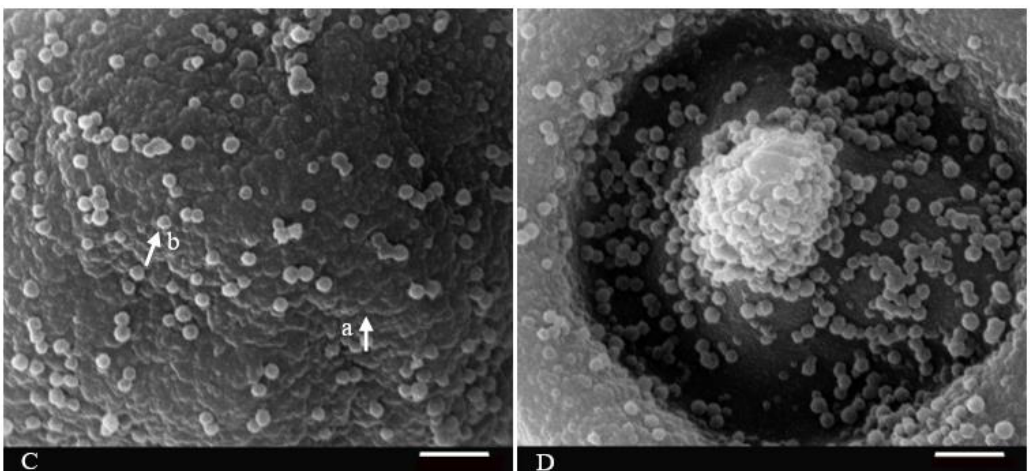
Figure 2. SEM photographs of pollen grains of T. distichum var. distichum . ( A ) Equatorial view at 4000×. ( B ) Polar view at 4000×. ( C ) Equatorial view at 10,000× showing pollen exine with microverrucate ornamentation ( arrow a), on which many granular protrusions ( arrow b) are observed. ( D ) Polar view at 10,000×. Bars: ( A , B ) 5 μm. ( C , D ) 2 μm. The determination result of water content of pollen of T. distichum var. distichum Table 2. Variation of water content of T. distichum var. distichum pollen. TD-4 and TD-5 are shown in Table 2. With the extension of storage time, the pollen water content of TD-4 and TD-5 decreased gradually, and the water content of fresh pollen was T. distichum var. distichum the highest, and the water content of pollen after three years storage was the lowest. In Storage Time addition, after the first year of storage, pollen water content decreased the most, from 24.46% and 24.38% of fresh pollen to 14.35% and 15.48% of pollen after storage for one year, and pollen water content decreased by 41.33% and 36.51%, respectively.